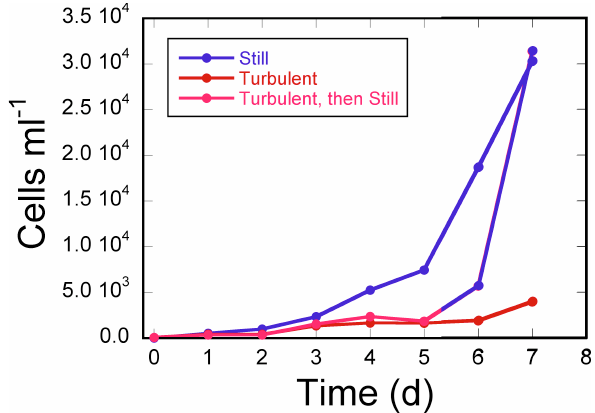
Fig. 3. Increase in cell concentration over time of the dinoflagellate Oxyrrhis marina in containers subjected to turbulence (red), left still (blue) and started turbulent and switched to still at day 5